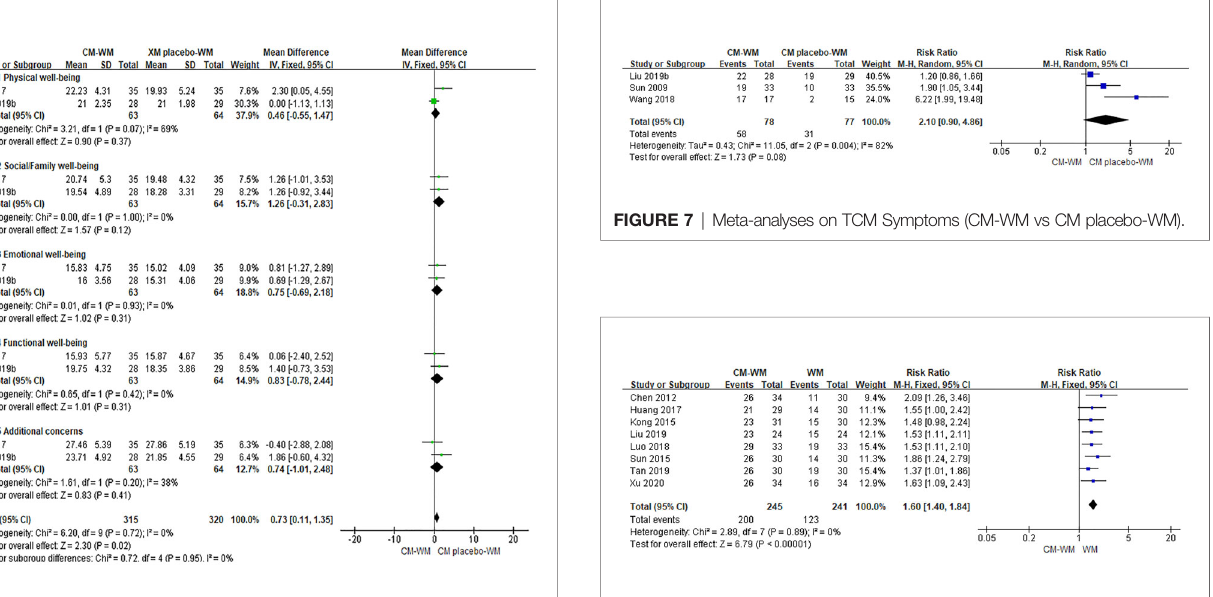
FIGURE 8 | Meta-analyses on TCM Symptoms (CM-WM vs WM).